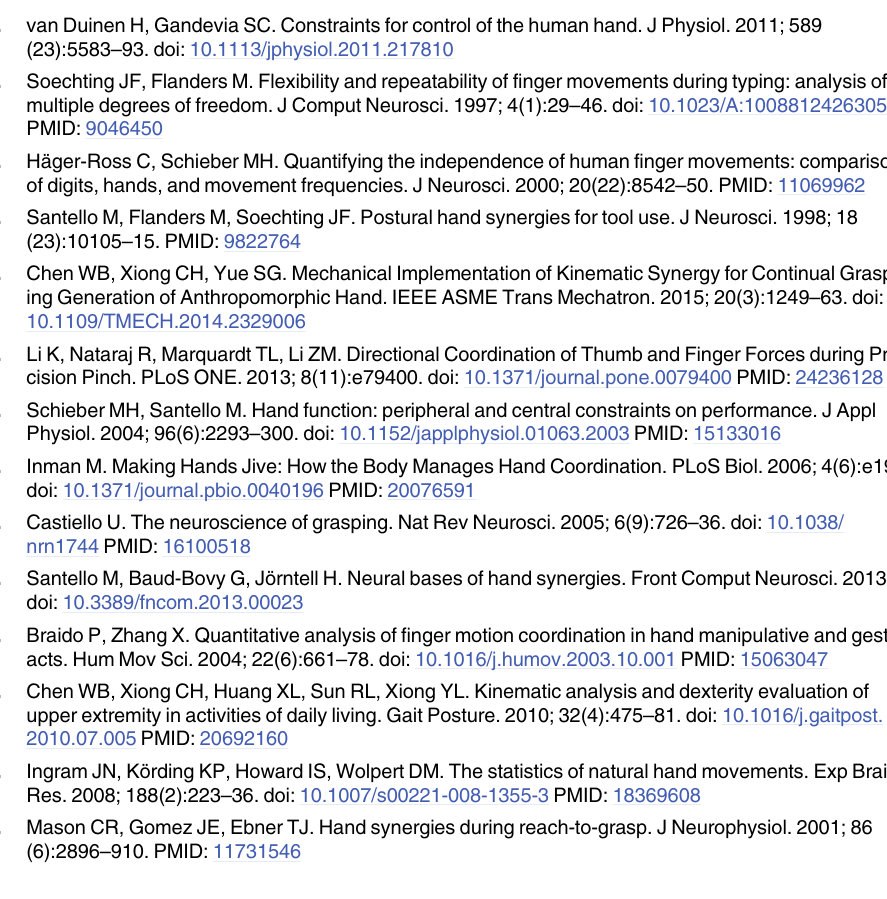
S5 Fig. Anatomy of the finger of right hand. (A) Radial view of finger. (B) Dorsal view. Black arrows indicate pull of long extensor tendon; red arrows indicate pull of interosseous and lumbrical muscles; dots indicate axis of rotation of joints (the image is adapted from Netter Image, 2014, with